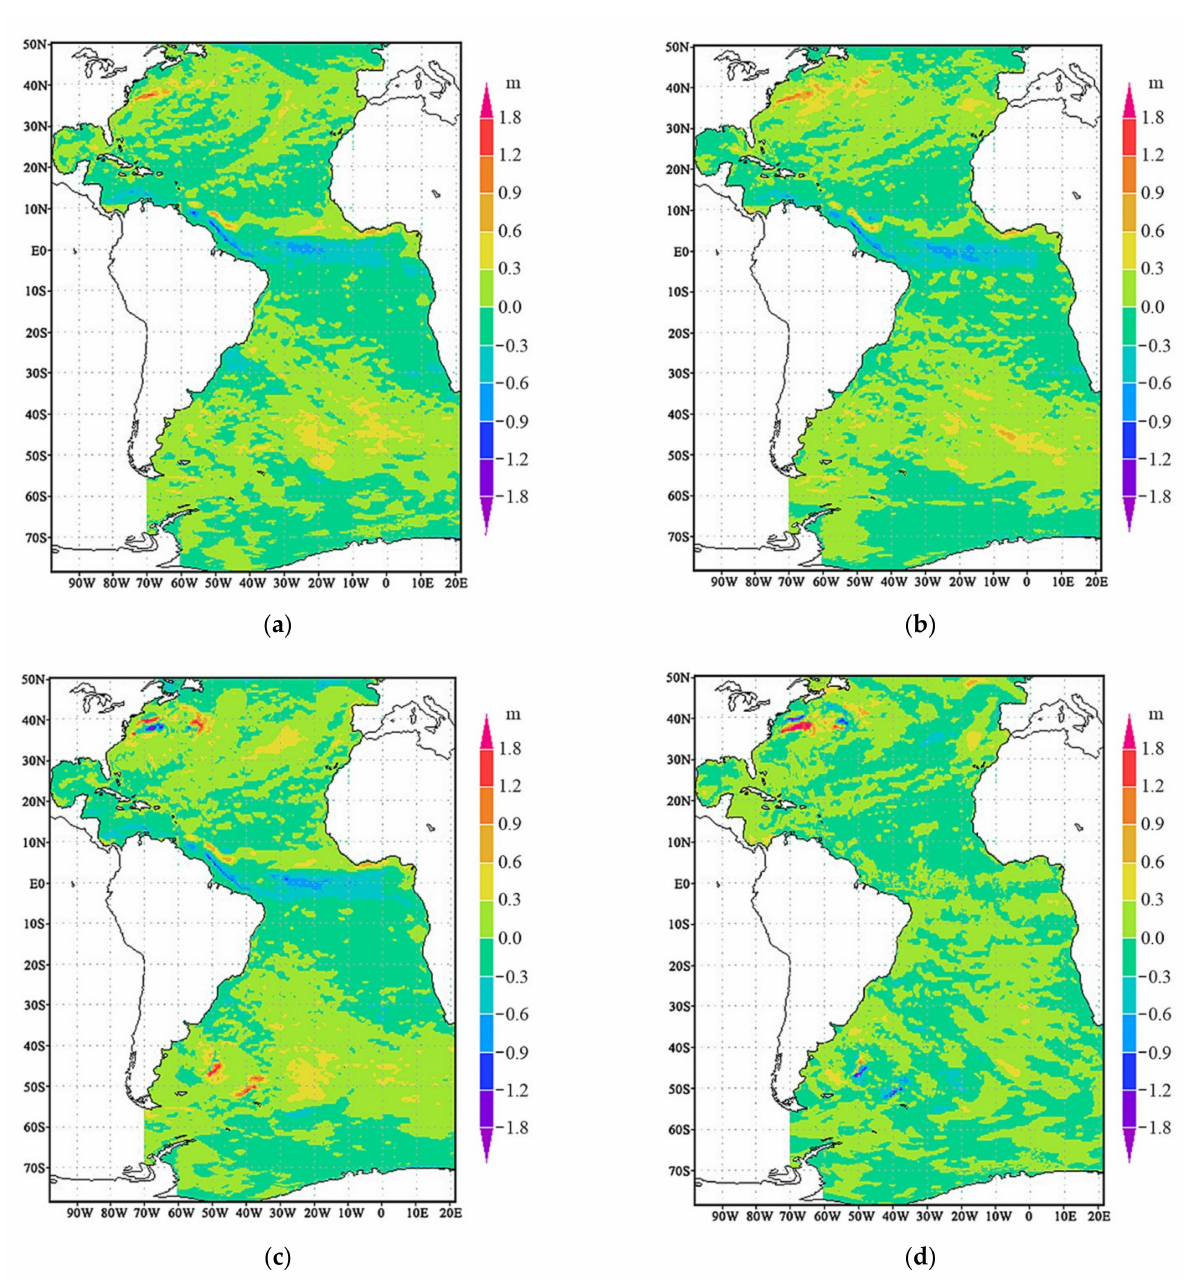
Figure 4. The results of computation of SLA on 27 January 2010: ( a ) control run; ( b ) assimilation by EnOI; ( c ) assimilation by GKF; ( d ) the difference between SLA calculated by EnOI and GKF (EnOI minus GKF)